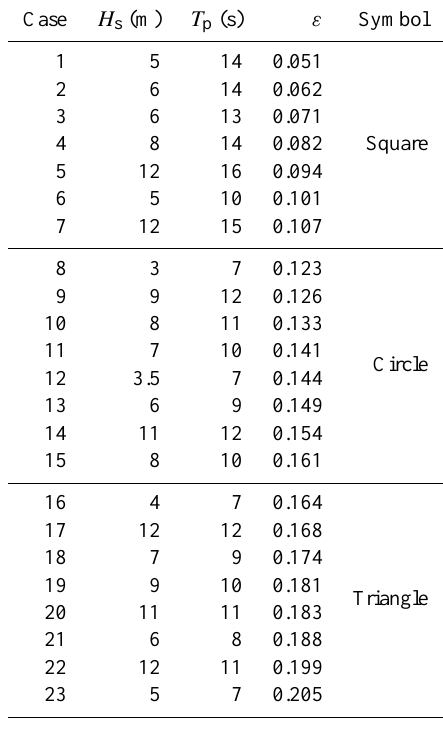
Table 1. Locations of wave gauges. Table 2. Parameters in different sea states.